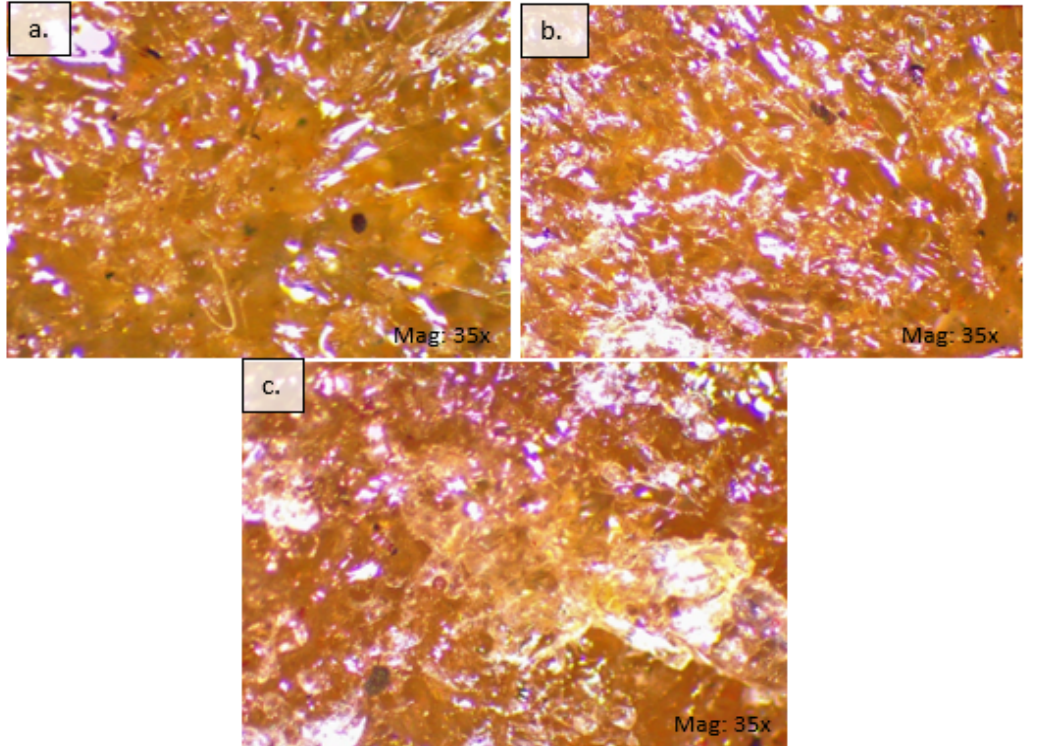
Figure 12. Fracture surfaces of 212 µm filler-reinforced composites under different strain rates: ( a ) 0.00028 s −1 , ( b ) 0.00085 s −1 , and ( c ) 0.0017 s −1 .